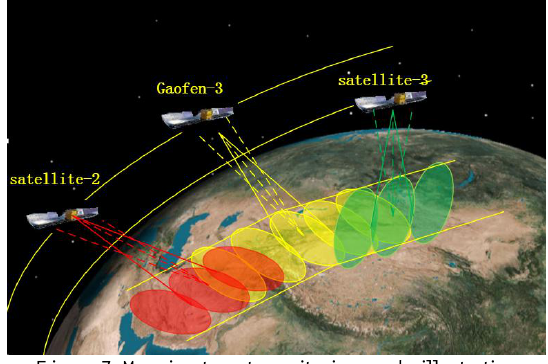
Figure 7. Moving target monitoring mode illustration In this mode, each SAR works in the dual-receiving channel (DRC) mode, while Gaofen-3 is side-looking, satellite-2 and satellite-3 are forward-looking and backward-looking. The SAR antenna of Gaofen-3 is 7.5m in azimuth direction as shown in Figure 8. While working in the DRC mode, the receive centers have a distance of 3.75 m. With such an along-track baseline, the maximum unambiguous radial velocity